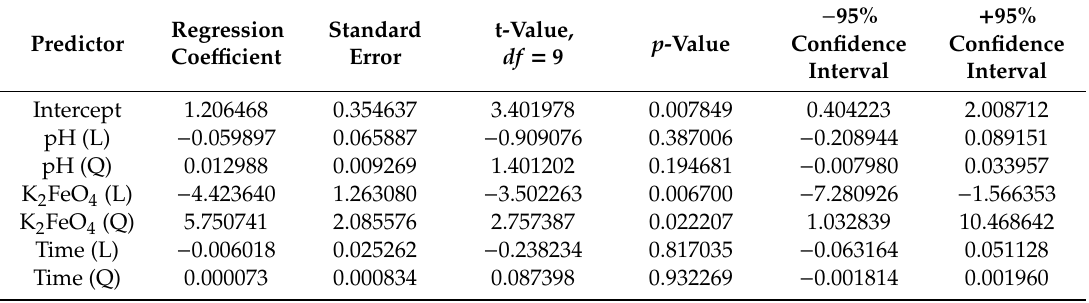
Table 5. Coe ffi cients of the fitted